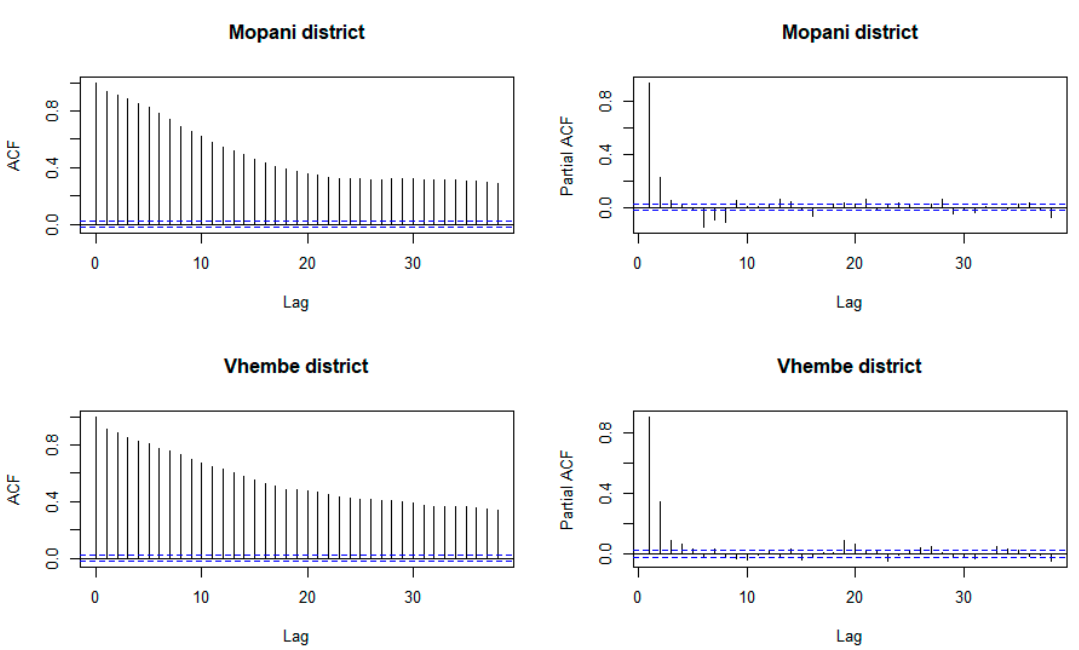
Figure 5. Plot of autocorrelation function and partial autocorrelation function of residuals of ZINB model for Mopani and Vhembe district municipalities.